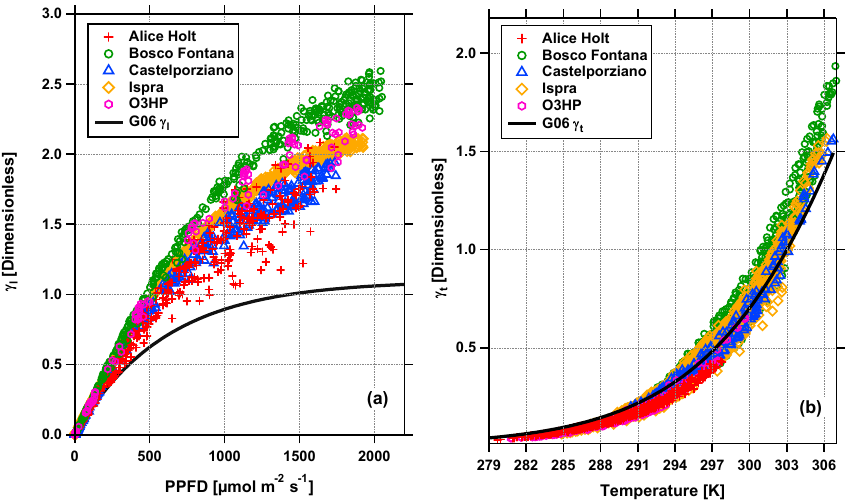
Figure 7. Light (a) and temperature (b) response curves from the G06 algorithm (see text for details) for the five measurement sites. The solid black lines show the light and temperature response curves when the previous light and temperature are held at standard conditions (200µmolm − 2 s − 1 and 297K for the previous 24 and 240h of light and temperature,